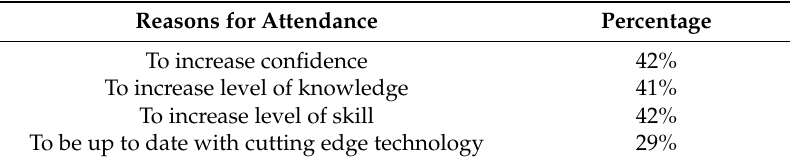
Table 2. Illustration of the main reasons for attending the programme.